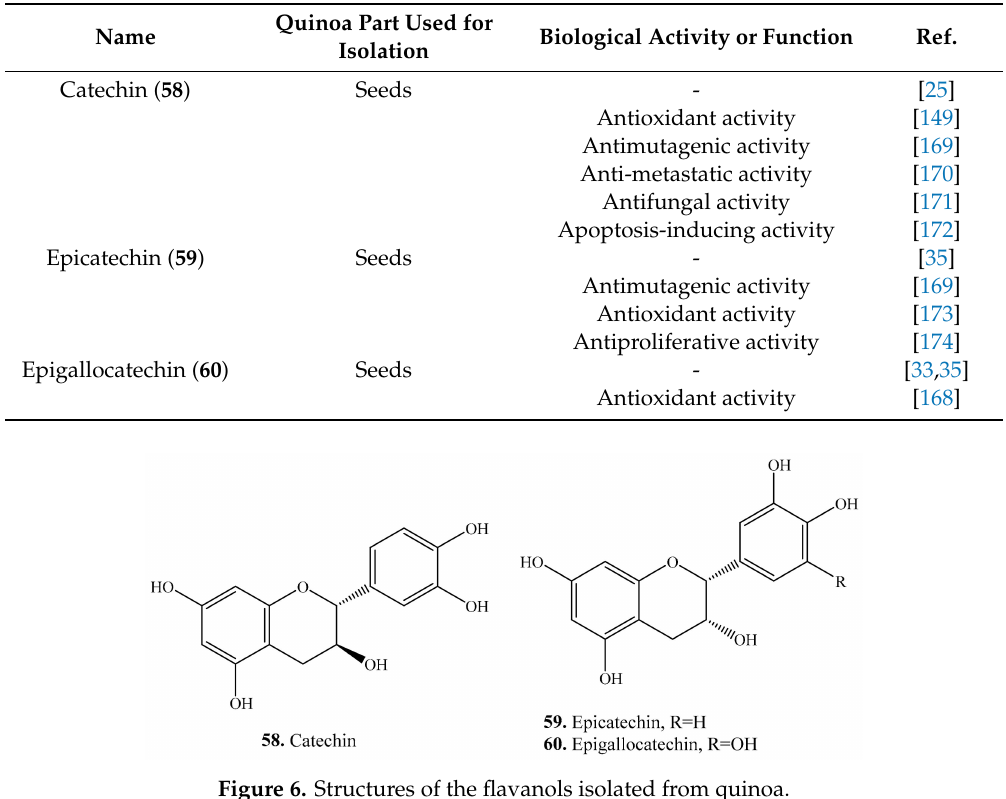
Table 6. Flavanols and their biological activities or functions.